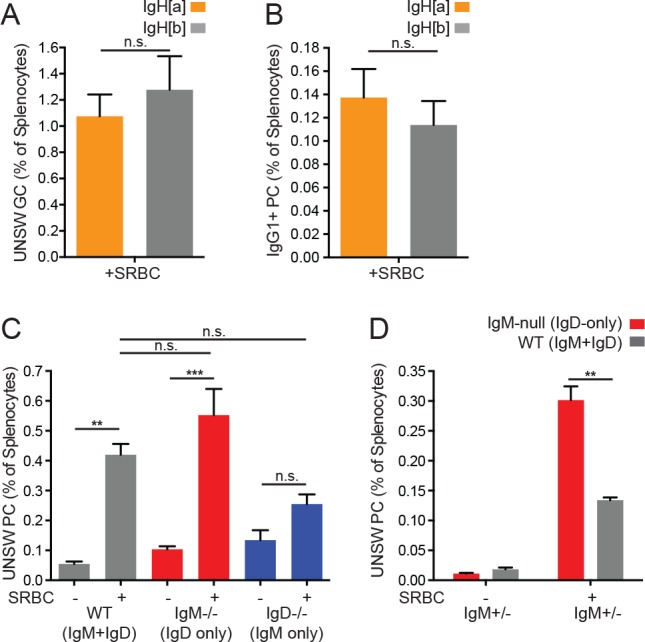
Role of BCR allotype and generation of unswitched plasma cells in SRBC-immunized mice.(A) Quantification of IgMa+ and IgMb+ germinal center B cells (CD19+FashiGL-7hi) as a percentage of live splenocytes in IgHa/b mice 5 days after i.p. immunization with 200 μL of 10% SRBCs. (B) Quantification of IgMa+ and IgMb+ plasma cells (CD138+) as a percentage of live splenocytes in IgHa/b mice 5 days after i.p. immunization with 200 μL of 10% SRBCs. (C) Quantification of splenic unswitched (IgM +or IgD+) CD138+ plasma cells from WT, IgM−/−, and IgD−/− mice unimmunized or 5 days after i.p. immunization with 200 μL of 10% SRBCs. (D) WT (IgMb+) and IgM-null (IgDa+) unswitched plasma cells (CD138+) as a percentage of live splenocytes in IgM+/− mice unimmunized or 5 days after i.p. immunization with 200 μL of 10% SRBCs. For (A) and (B), n = 3 mice were analyzed. Paired t tests (A-B and D) and one-way ANOVA with Tukey’s multiple comparisons test were used to calculate p values, and mean +SEM is displayed. For (C), cell numbers from n = 4 umimmunized mice of each genotype and n = 3 WT, n = 6 IgM−/−, and n = 7 IgD−/− immunized mice were analyzed. For (D), n = 5 unimmunized and n = 5 immunized were analyzed. **p<0.01, ***p<0.001.